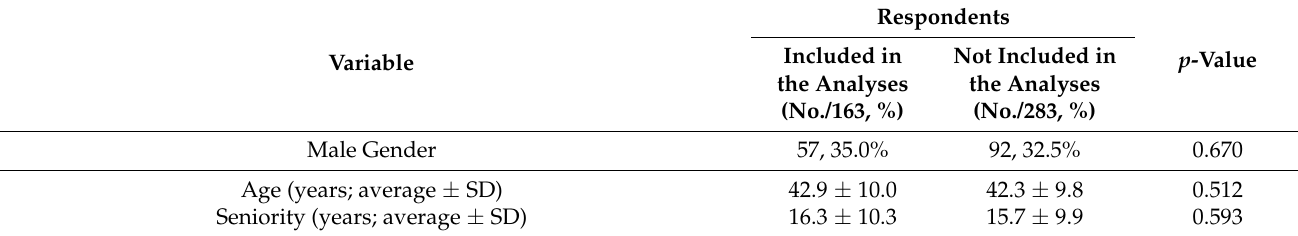
Table A1. Demographic characteristics of the respondents included (i.e., medical